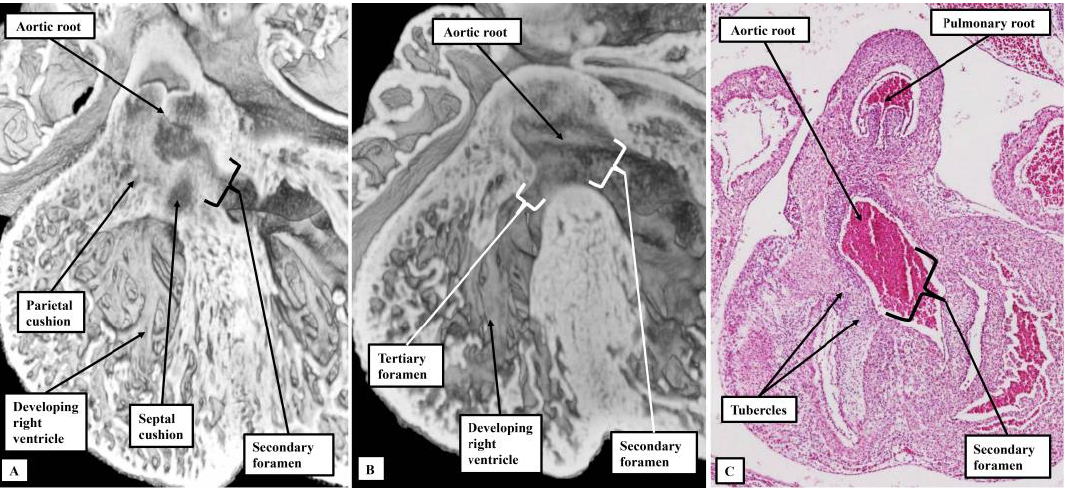
Figure 2. The images show the changes involved during transfer of the aortic root from the developing right to the developing left ventricle. Panels ( A , B ), in four chamber projection, are from the same mouse embryo sacrificed at embryonic day 13.5. Panel ( A ) shows how the proximal outflow cushions have fused to produce a partition at the base of the ventricle beneath the aortic root. Panel ( B ), a dorsal section from the same heart, shows how a tertiary foramen remains between the root and the cavity of the right ventricle. Panel ( C ), from a human embryo at Carnegie stage 21, shows how tubercles derived from the atrioventricular cushions close this tertiary foramen, becoming the membranous part of the ventricular